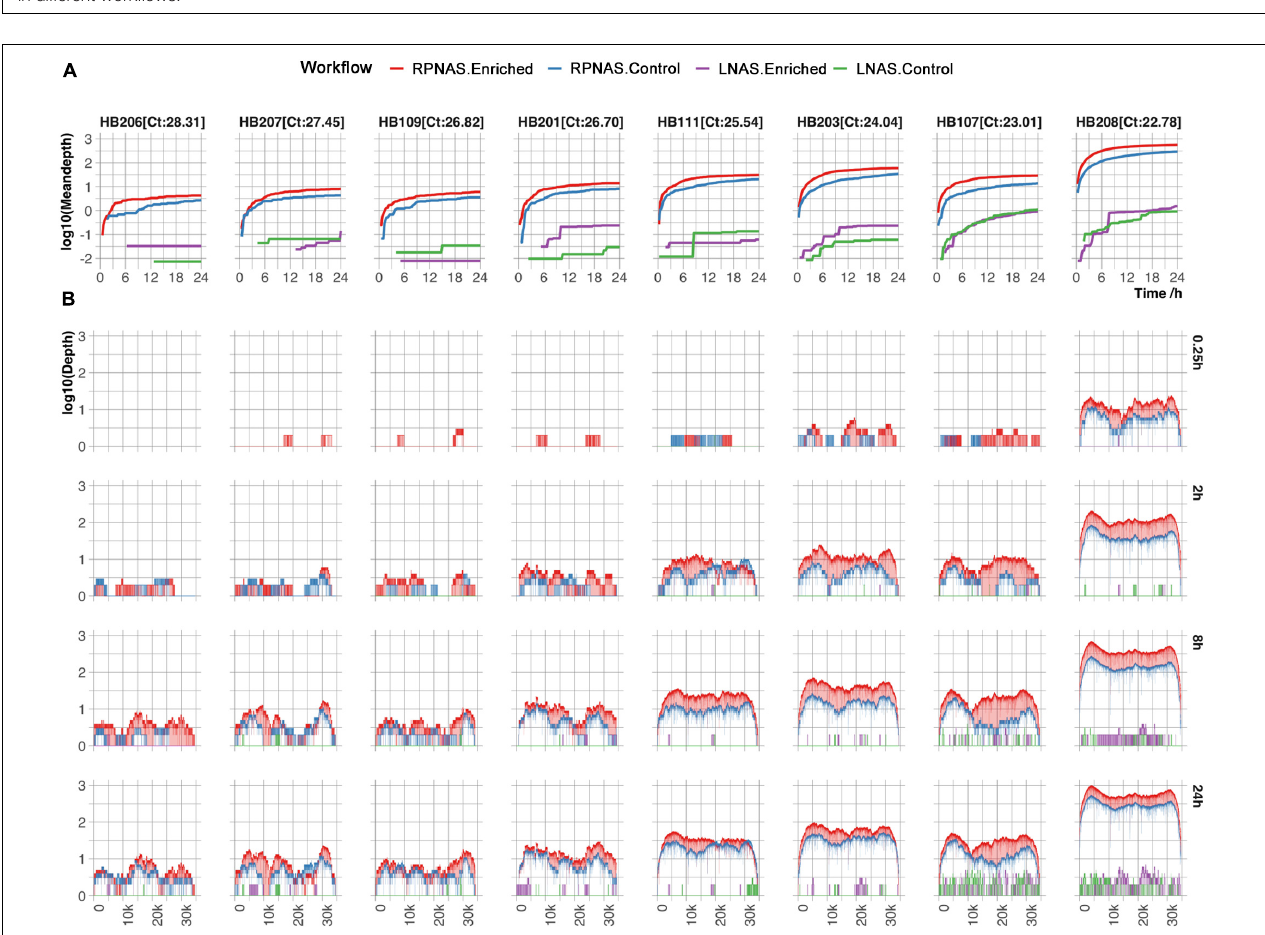
FIGURE 3 | Comparison of HAdV enrichment in eight samples with different workflows. (A) The mean depth of the HAdV genomes changed over 24 h of sequencing. (B) Coverage of HAdV genomes at the different timestamps (0.25, 2, 8, and 24 h). Red, blue, purple, and green lines represent the enriched group in RPNAS workflow, the control group in RPNAS workflow, the enriched group in LNAS workflow, and the control group in LNAS workflow,